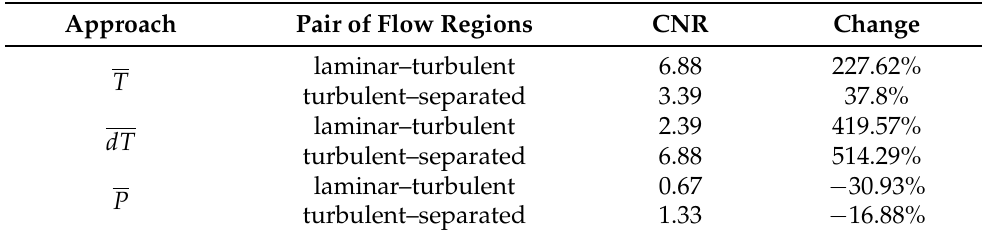
Table 2. Comparison of the contrast to noise ratio for the proposed signal processing approaches for a transient input signal: mean temperature T , gradient-based dT , harmonic signal process- ing approach P . Additionally, a comparison of the respective CNR change for the different measurement